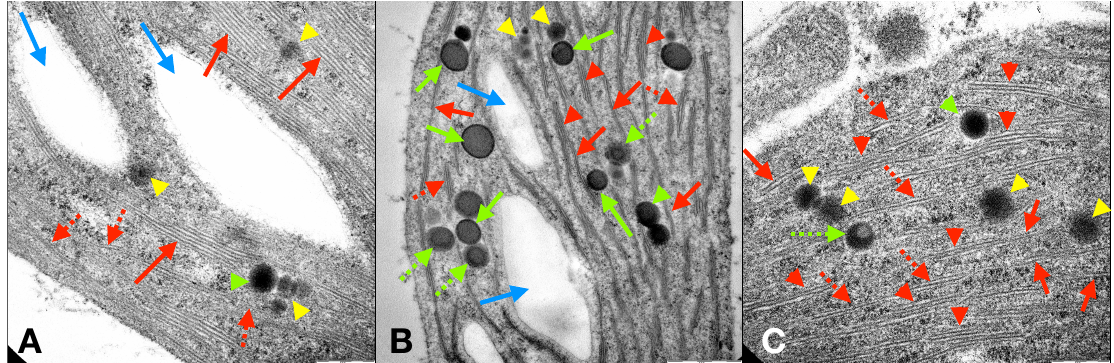
Figure 5. TEM micrographs of Lemna minor L. chloroplast ultrastructures in leaf cell cross-sections from plants grown in the presence of total Fe supply (C + control) ( A ), in total Fe deprivation (C − ) ( B ), and in the presence of C 2 L-NMs and insoluble iron (FeCl 3 ). Graphical arrows and arrowheads in the micrographs represent the following: ( A ) light blue arrows = starch granules; solid red arrows = stacked thylakoids in grana; dotted red arrows = single thylakoid stromal lamellae; yellow arrowheads = Type2 plastoglobules (PGs); green arrowheads = Type1 PGs. ( B ) light blue arrows = starch granules; solid red arrows = double thylakoid stromal lamellae; dotted red arrows = grana composed of three stacked thylakoids; red arrowheads = grana composed of ≥ four stacked thylakoids; yellow arrowheads = Type2 PGs; green arrowheads = Type1 PGs; solid green arrows = Type3 PGs; dotted green arrows = Type4 PGs. ( C ) solid red arrows = single thylakoid stromal lamellae; dotted red arrows = double thylakoid stromal lamellae; red arrowheads = grana composed of ≥ three stacked thylakoids; yellow arrowheads = Type2 PGs; green arrowhead = Type1 PG; dotted green arrow = Type3 PG. Scale bars in the micrographs correspond to 200 nm ( A , C ) and 500 nm ( B ).